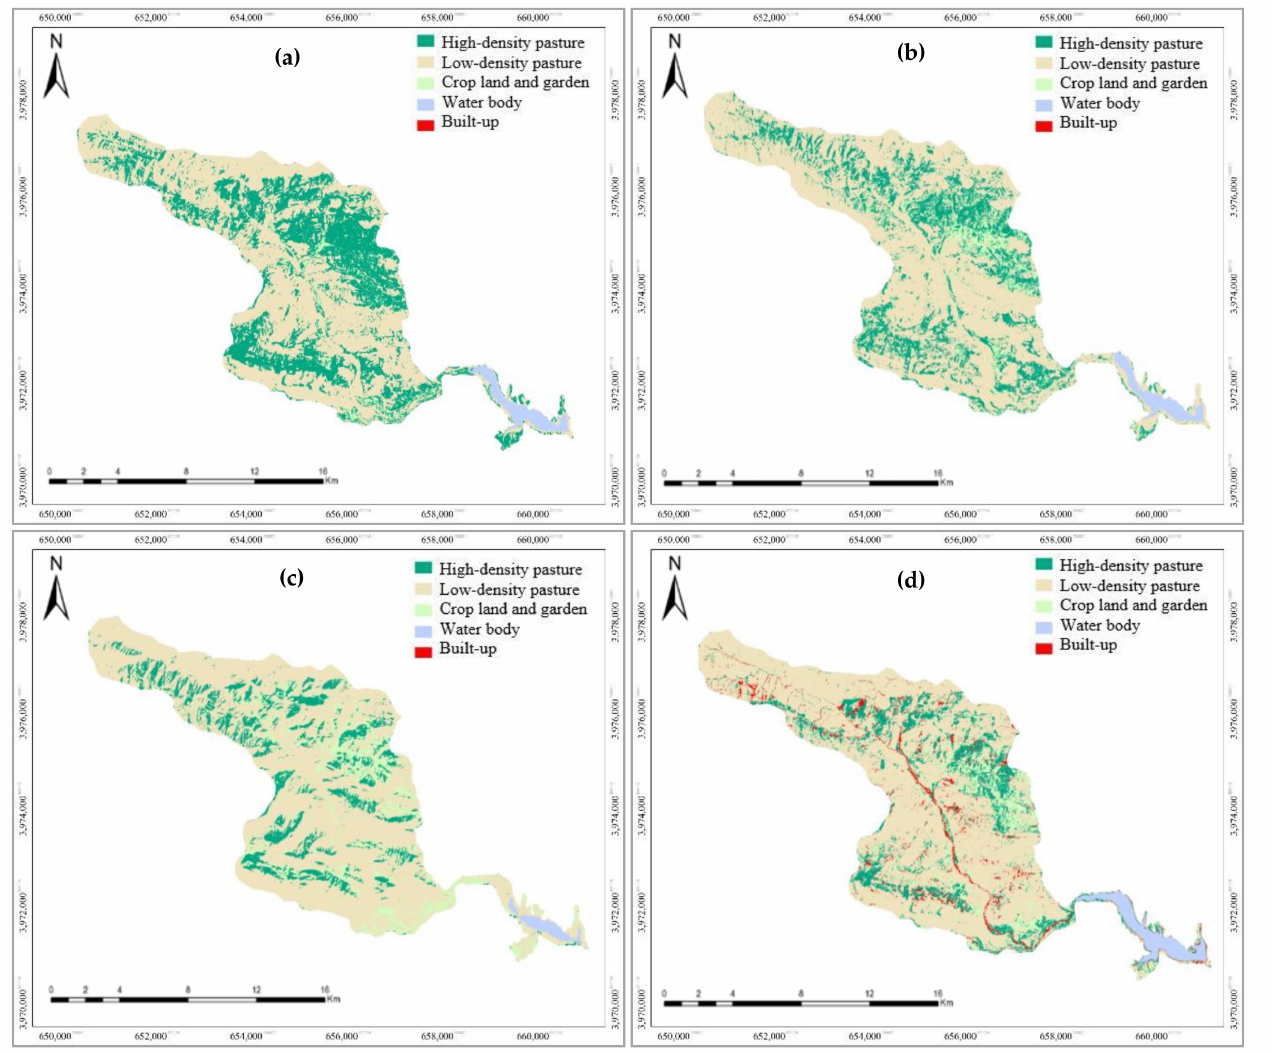
Figure 4. Temporal LULC maps in Lar; ( a ) 1989, ( b ) 1999, ( c ) 2009, ( d ) 2019. The results indicate that in Jajrud PA, high-density pasture experienced the highest rate of area decrease with 37.71% (28,540 ha) in 2019 compared to 38.64% (29,241 ha) in 1989. Low-density pasture also decreased during the studied years, with 44.85% (33,938